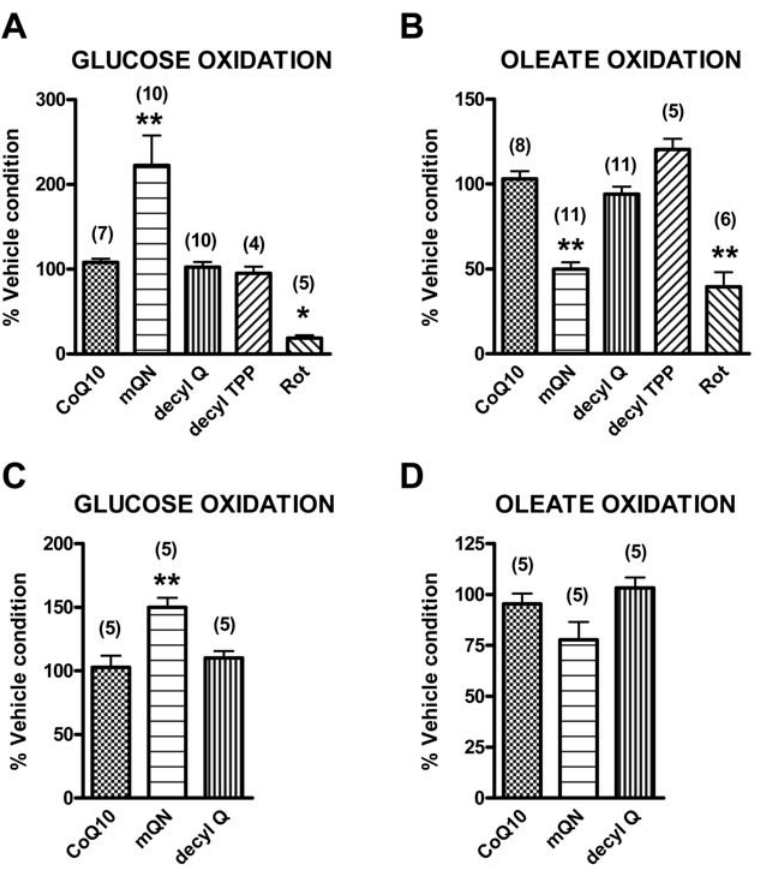
Figure 7. Effect of mitoquinone or control compounds on glucose and oleate oxidation. BAE cells were preincubated for 20 min in the presence of culture medium with 5.5 mM glucose plus 200 m M oleate (panels A and B) or 5.5 mM glucose plus 10 m M oleate (panels C and D). D- [ 14 C(U)]glucose (panels A and C) or [1- 14 C]oleic acid (panels B and D) were added at time 0 and cells incubated for 120 min before trapping CO 2 . Final glucose and oleate concentrations after addition of label were 5.6 mM glucose + 200 m M oleate (panel A), 5.5 mM glucose + 206 m M oleate (panel B), 5.6 mM glucose + 10 m M oleate (panel C) and 5.5 mm glucose + 15.7 m M oleate (panel D). 1.0 m M mitoquinone or control compounds or 5 m M rotenone (Rot) were added at time 2 20 min and continued during subsequent incubation. Data are expressed relative to incubation in the presence of vehicle alone, a condition included for study of each cell preparation. Numbers in parentheses designate number of preparations. Data represent mean 6 SE, * p , 0.05 or ** , 0.01 compared to non-targeted CoQ10 by one-way ANOVA.